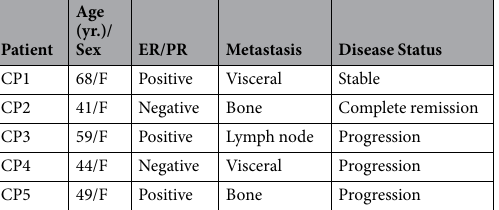
PBMCs (Fig. 3A and Supplementary Figure S5). Contrary to what observed for cellular lines, no spurious EpCAM positive events were observed by both flow cytometry and optofluidics. On the other hand, the number of HER2 positive events was notably larger. In the case of the flow-cytometer, such increase in the number of HER2 posi- tives can be ascribed to expression, although low, of HER2 receptors in the NK/granulocyte population 49 . For the optofluidic chip, this biological factor is further combined with the additional background cell auto-fluorescence which is collected at the green channel. Once defined the thresholds associated with positive events for both green (antiHER2) and red (antiEpCAM) labels, flow cytometry and optofluidic measurements were per- formed on blood samples from cancer patients (Fig. 3B and Supplementary Figure S5). CTCs were quantified in similar amounts, with both methods (Fig. 3D), for four of the five patients but with one presenting none (CP2). These data correlate well with those obtained with conventional diagnosis at the sample extraction (Table 1 and Fig. 3C). First, samples which show low CTC counts (CP1 and CP5) present a stabilised lung metastasis (CP1) and a malignant pleural effusion and mediastinal mass (CP5), which is still in progression but after four cycles